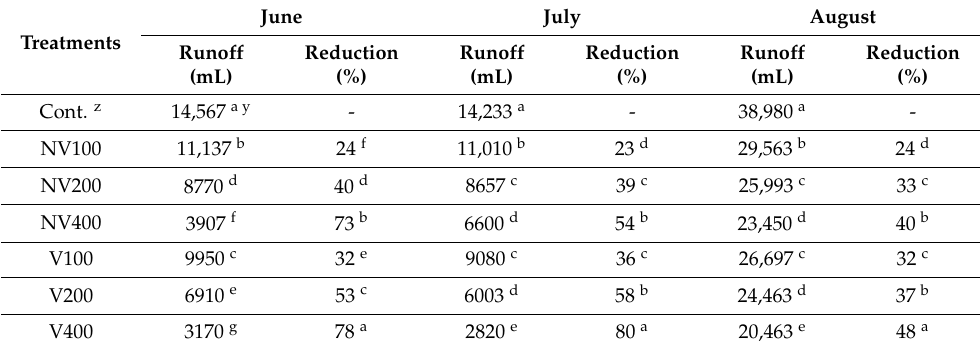
Table 1. Runoff reduction from different substrate depths and vegetation plots based on rainfall intensity.